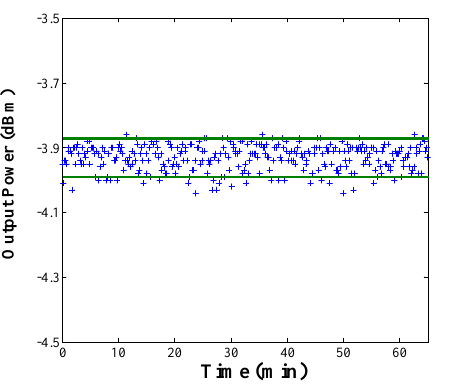
Figure 8. Output power stability measured for 60 min with constant pump power (100 mW) when 2 m of EDF I25 was used.